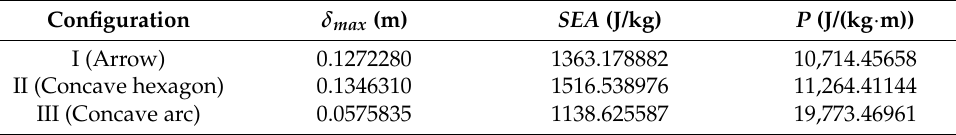
Table 6. Anti-blast indices of the three configurations.